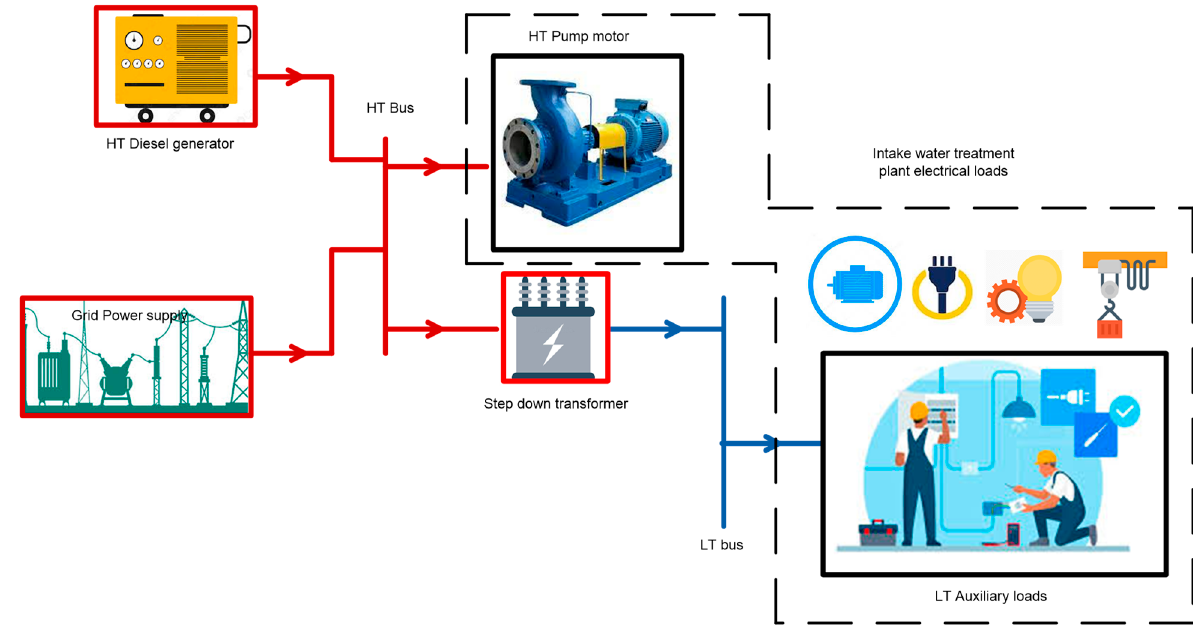
Figure 1. SLD of typical Intake